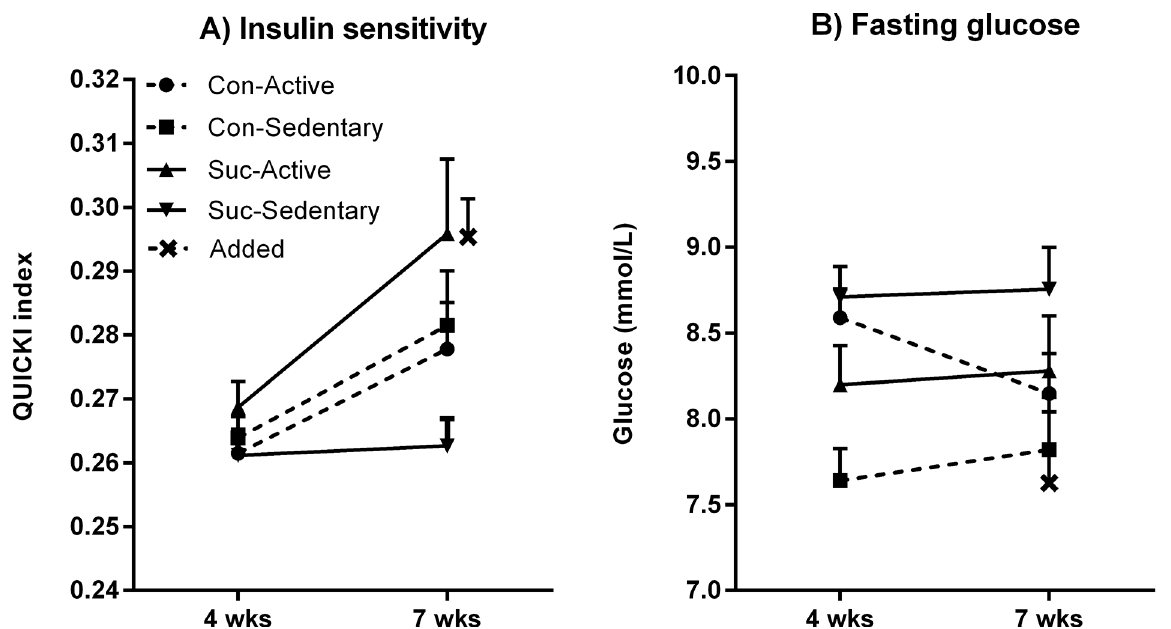
Fig 8. Metabolic measures in Stage 3. Panel A: At 7 weeks insulin sensitivity was increased by activity in the offspring of sucrose-fed mothers (Sucrose- Active vs . Sucrose-Sedentary groups) but no such effect was detected in the offspring of control mothers (Control-Active vs . Control-Sedentary groups). Panel B: Fasting blood glucose levels were higher overall in the offspring of sucrose-fed mothers than in offspring of control mothers, and when the Added group was measured at 7 weeks its levels were lower than those of the Sucrose-Sedentary group but not significantly different from those of the Sucrose- Active group. ** p =